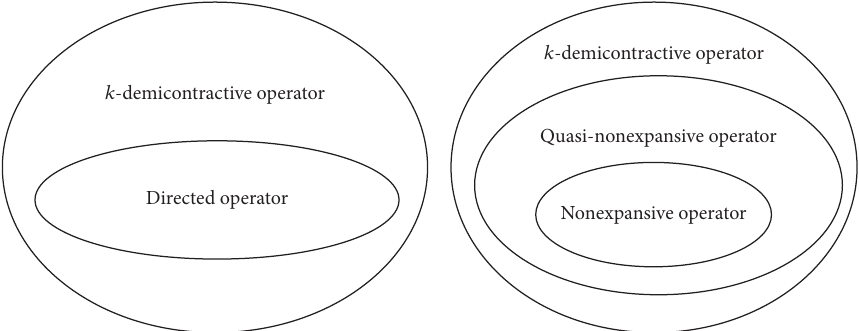
Figure 1: The relations of 𝑘 -demicontractive operator, directed operator, quasi-nonexpansive operator, and nonexpansive